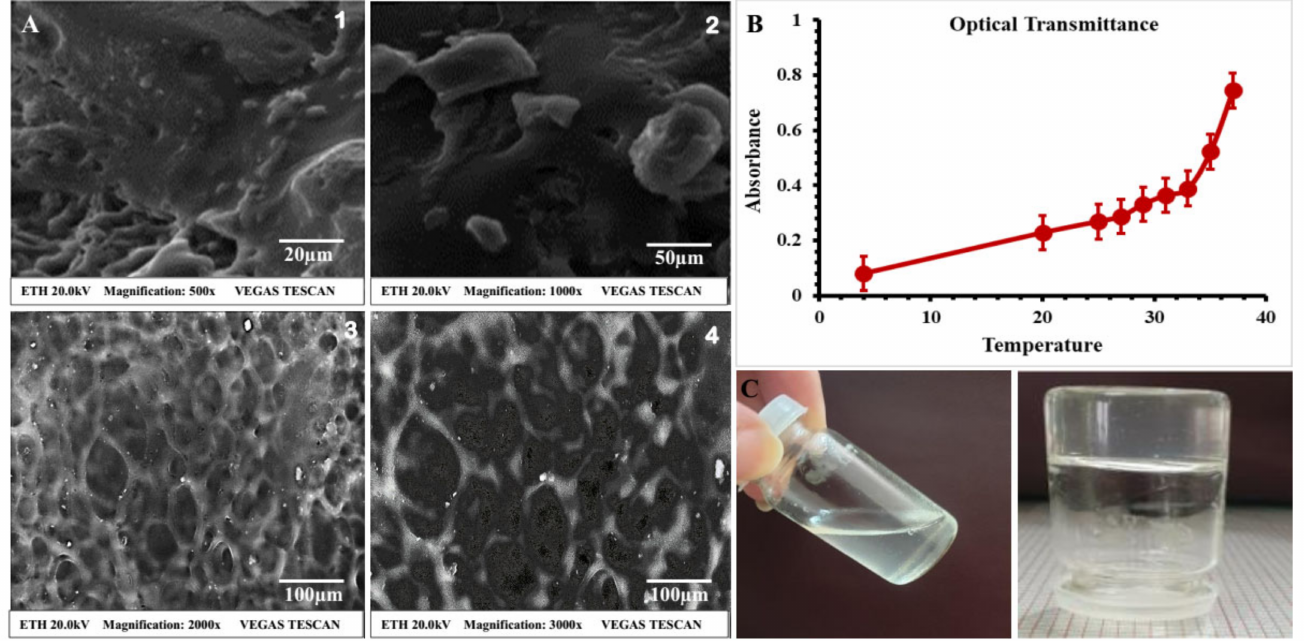
Figure 3. ( A ) Cross-sectional SEM micrograph views of injectable hydrogel at various magnifications to access the porosity in the network: ( 1 ) at a magnification of 500 × ; ( 2 ) 1000 × magnification; ( 3 ) 2000 × magnification; and ( 4 ) magnification 3000 × . ( B ) Optical transmittance and temperature- induced changes of the thermosensitive hydrogel at various temperatures. ( C ) Visual representation of transparency of hydrogel and sol–gel phase transition in sol phase of prepared hydrogel and gel phase of prepared